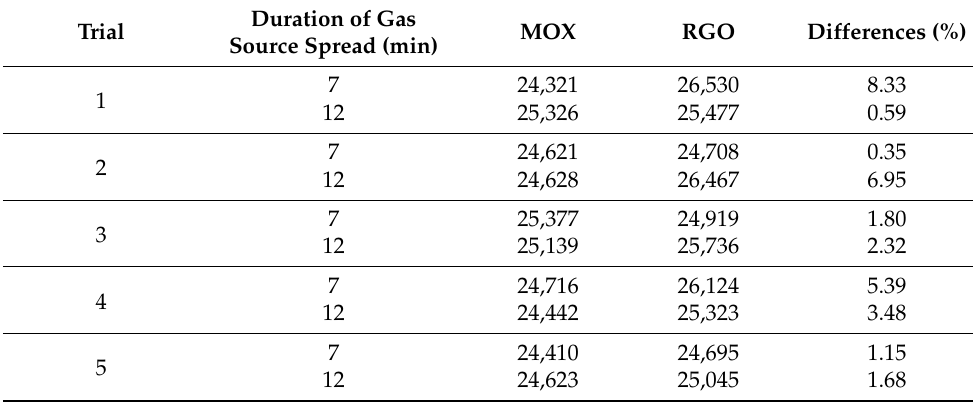
Table 5. Summation of pixel binary number 1 (white area).